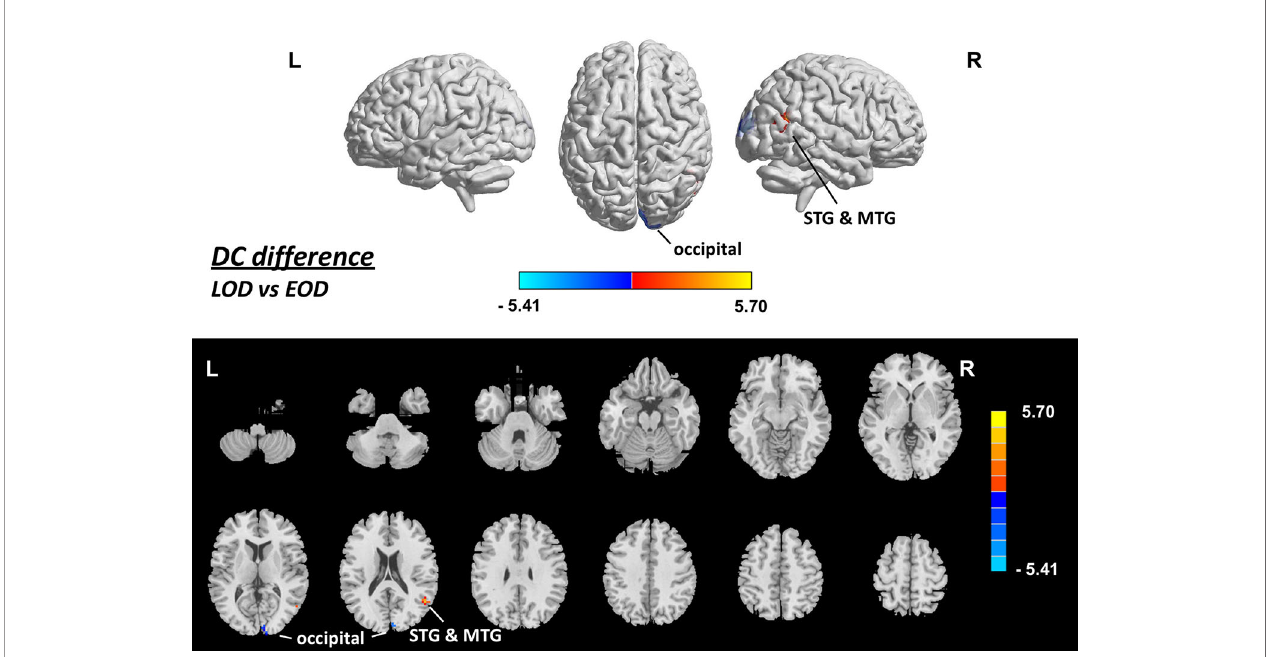
FIGURE 3 | Brain areas showing difference in DC between LOD and EOD patients ( p < 0.05, corrected), with gender, age, education, score on MMSE and framewise displacement regressed out. Upper: rendering views. Lower: axial slice views. Color bars indicate T -score; warm color indicates areas whose DC value in LOD patients > DC value in EOD patients, cold color indicates areas whose DC value in LOD patients < DC value in EOD patients. EOD, early-onset depression; HC, healthy control; L, left; LOD, late-onset depression; MTG, middle temporal gyrus; R, right; STG, superior temporal gyrus.